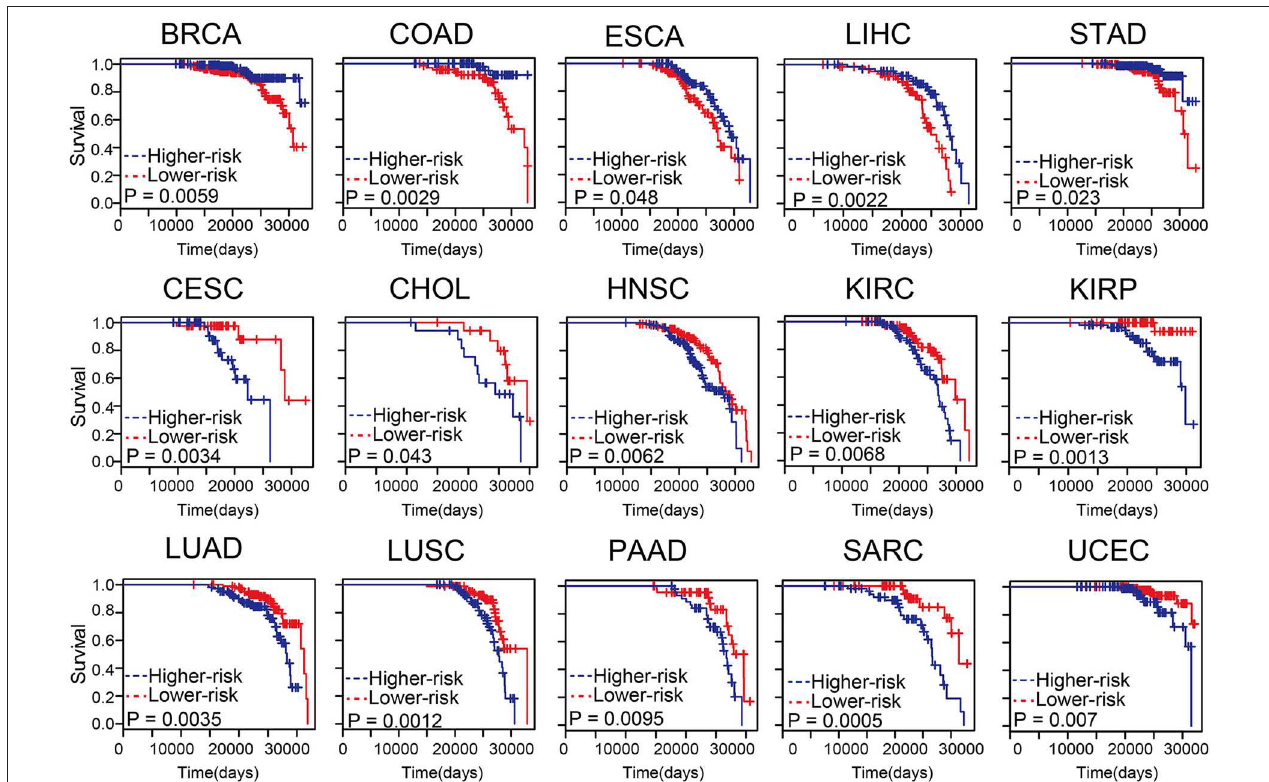
FIGURE 5 | The differential methylation sites in age-related samples were associated with survival. Kaplan-Meier survival analysis of two groups of patients with high- (blue line) and low- score (red line) groups. Survival days are shown along the X-axis. Overall survival rates are shown along the